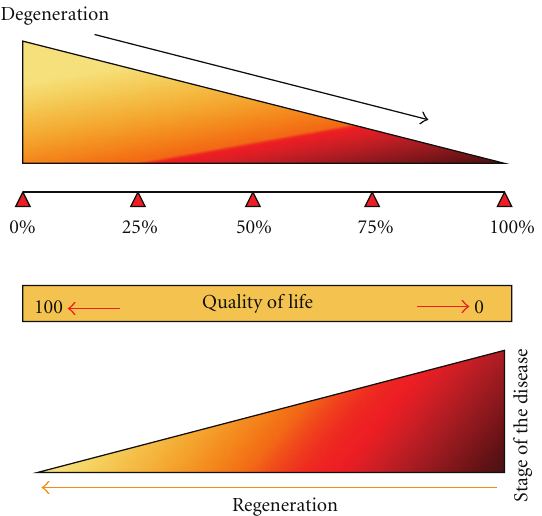
Figure 5: Depicts the balance between degeneration due to illness and the neuroregenerative reserve present in the brain. The schema- tic diagram illustrates that higher the degeneration higher the illness and more the regeneration required. Exogenous supply of stem cells midway between these two stages (i.e., 50%) would aid in improving the quality of life and reducing the disability due to